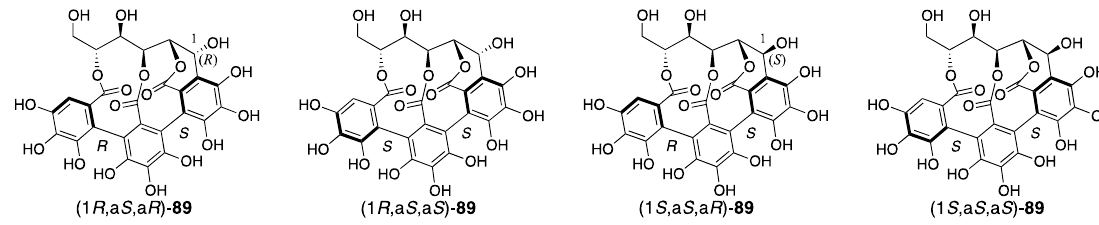
Figure 38. The computer-calculated compounds that led to the structural revisions of castalin and vescalin to the latest structures.